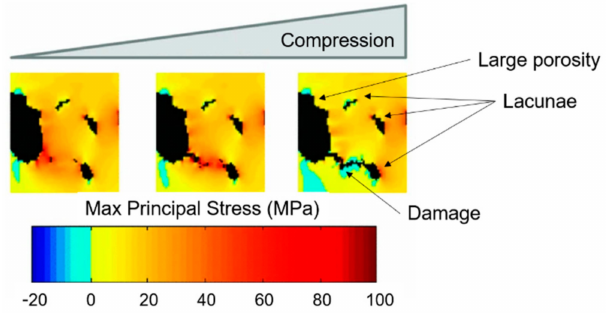
Figure 12. Stress gradient algorithm (on SR CT data from a cortical bone sample) results: damage starts from big porosities and its propagation follows the stress gradient. Micro-damage is deviated by the presence of lacunae. Readapted from